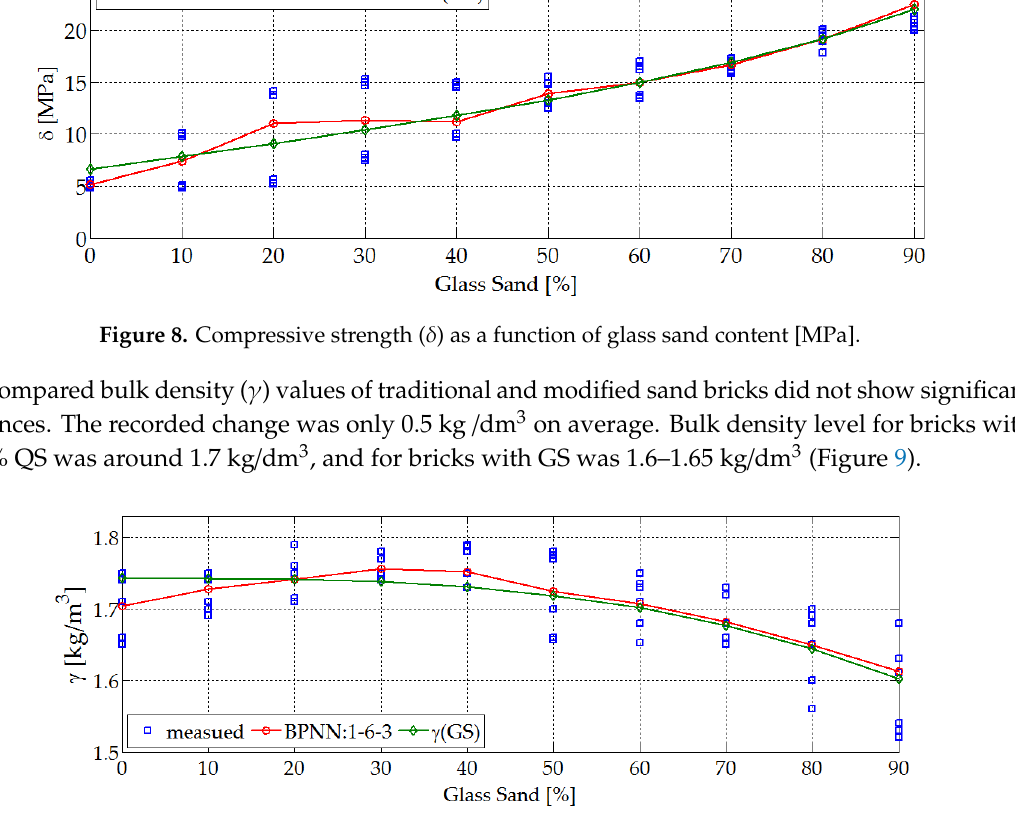
Figure 9 . Bulk density (γ) as a function of glass sand content